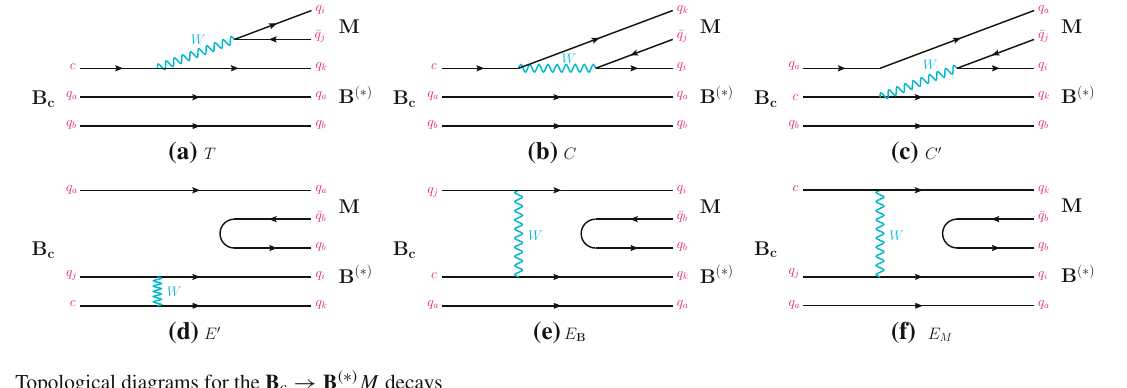
Fig. 1 Topological diagrams for the B c → B ( ∗ ) M